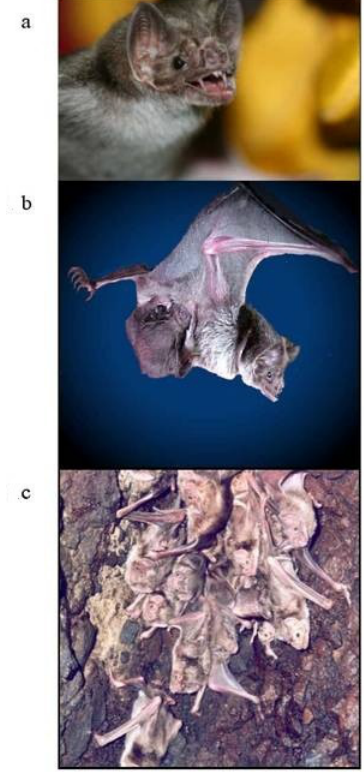
Figure 1. Images of the common vampire bat Desmodus rotundus . ( a ) A close up showing the sharp incisors used to puncture the skin of prey animals; ( b ) a female with young in flight; ( c ) a small colony of D. rotundus .